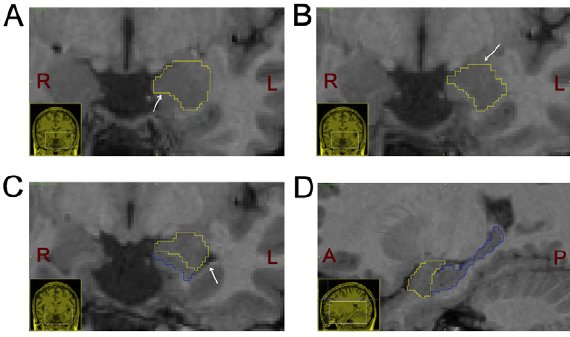
Figure 1. Manual delineation of the amygdala. A) The left amgydala section in the coronal plane. The yellow line represents the contour of amygdala and white arrow indicates its inferior border on coronal plane. Picture in lower left corner is the thumbnail of brain in coronal plane. L and R represent the left and right side, respectively. B) The left amgydala section in the coronal plane. The yellow line represents the contour of the amygdala and white arrow indicates its superior border. C) The left amgydala and hippocampus sections in the coronal plane. The yellow line represents the contour of amygdala and blue line describes the border of hippocampus, the white arrow indicates the temporal horn which begins to enlarge more superiorly along the lateral side of the two structures. D) The left amgydala and hippocampus sections in the sagittal plane. The yellow line represents the contour of amygdala and blue line describes the border of hippocampus. Picture in lower left corner is the thumbnail of the brain in sagittal plane. A and P represent the anterior and posterior side, respectively.